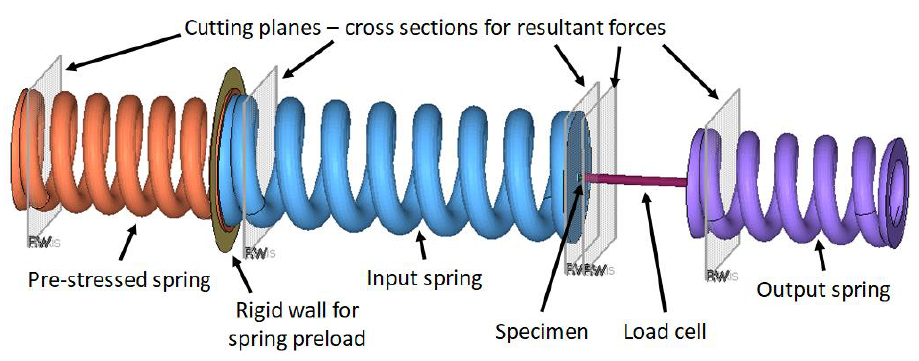
Fig. 1. Numerical model of the Hopkinson